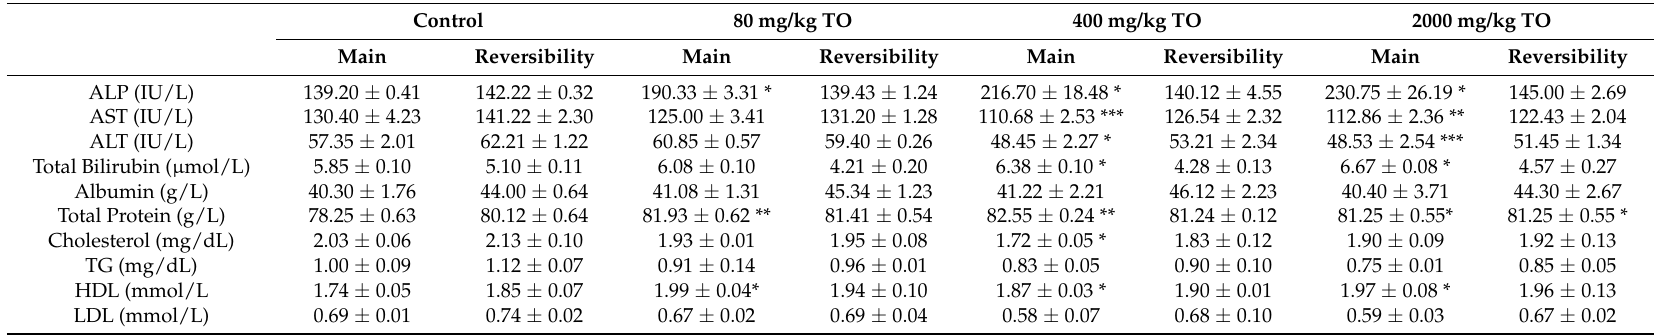
Table 4. Effect of T. occidentalis on biochemical parameters. Control